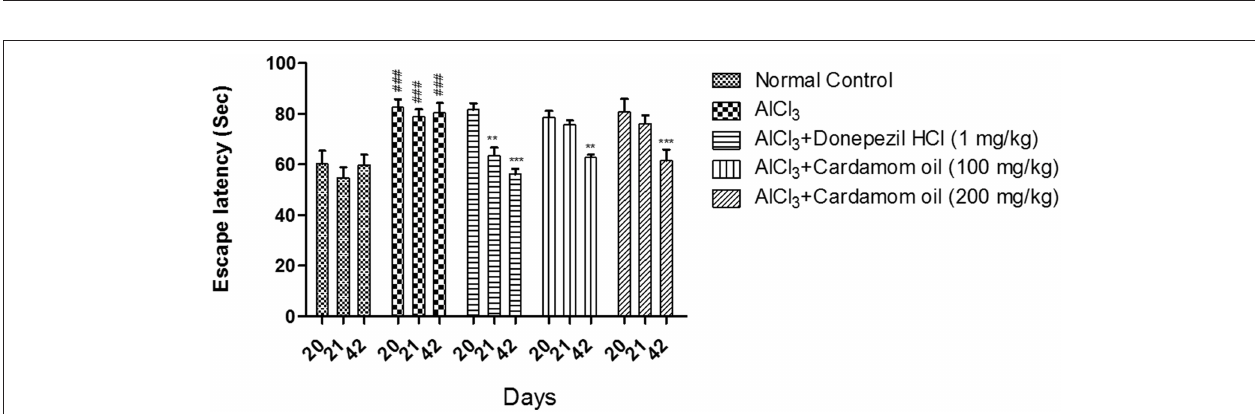
FIGURE 2 | Effect of Cardamom oil on Morris water maze test in AlCl 3 -induced neurotoxicity in rats. Data are expressed as mean ± SEM ( n = 6), ### p < 0.001 when compared with normal control, ** p < 0.01, *** P < 0.001 when compared with disease control group. AlCl 3 , Aluminum chloride; SEM, Standard Error of Mean.